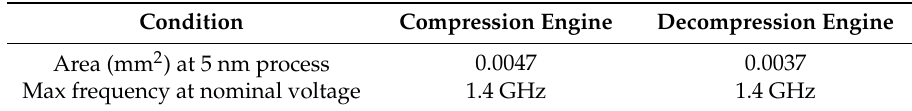
Table 12. Implementation